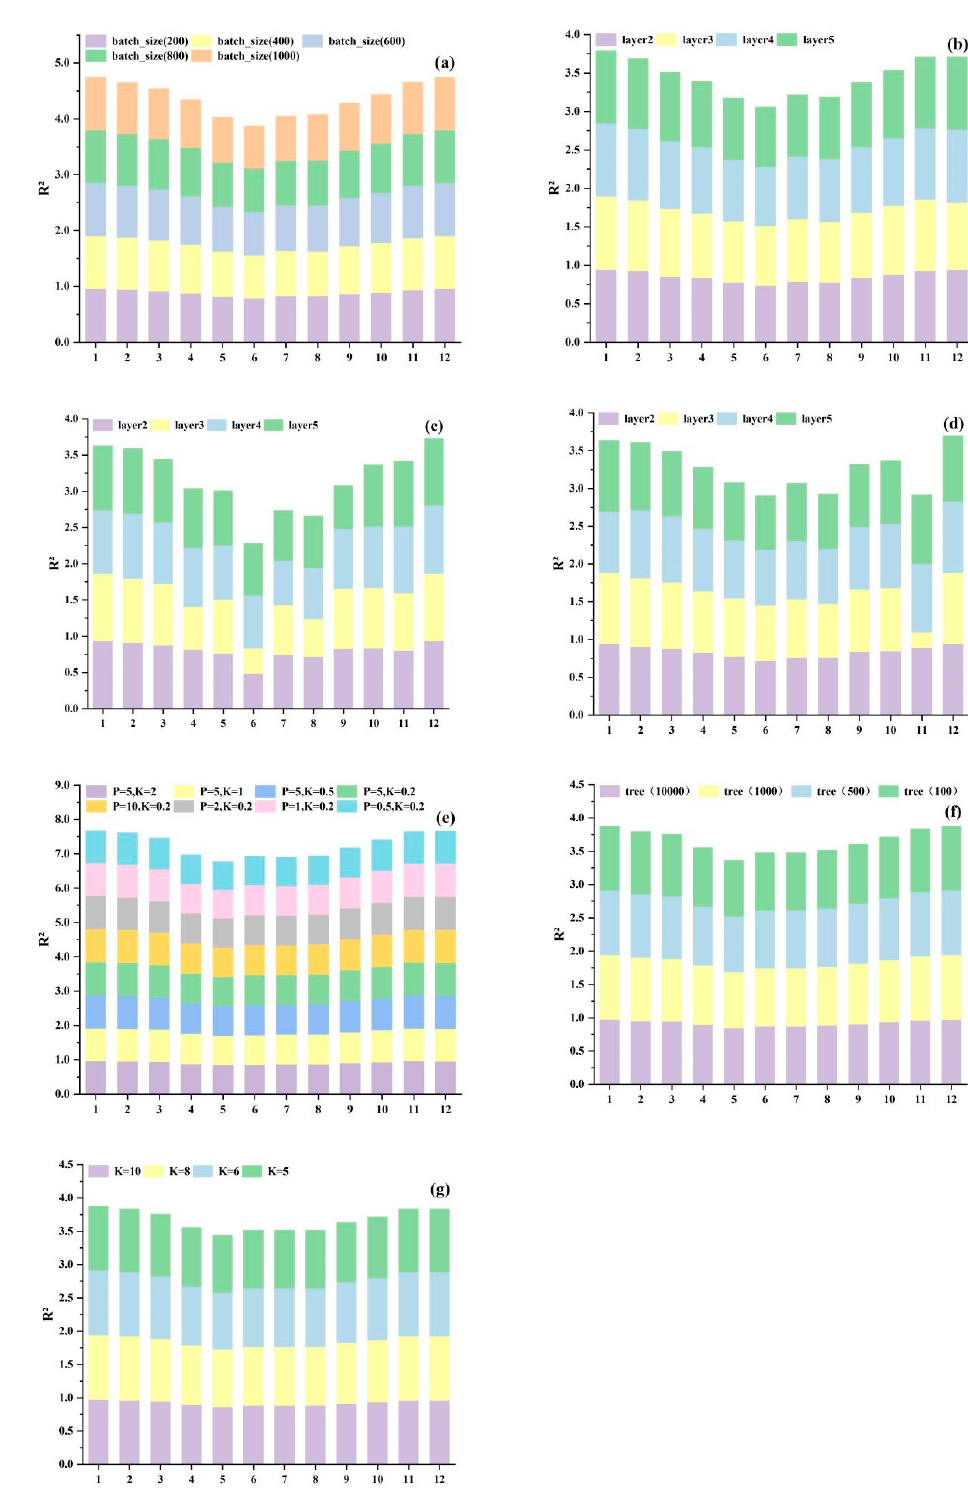
Figure 8. ( a ) NN tuning by batch size. ( b ) NN tuning by layer number. ( c ) LSTM tuning by layer number. ( d ) BiLSTM tuning by layer number. ( e ) SVM tuning situation. ( f ) RF tuning by number of random trees. ( g ) GPR tuning situation.